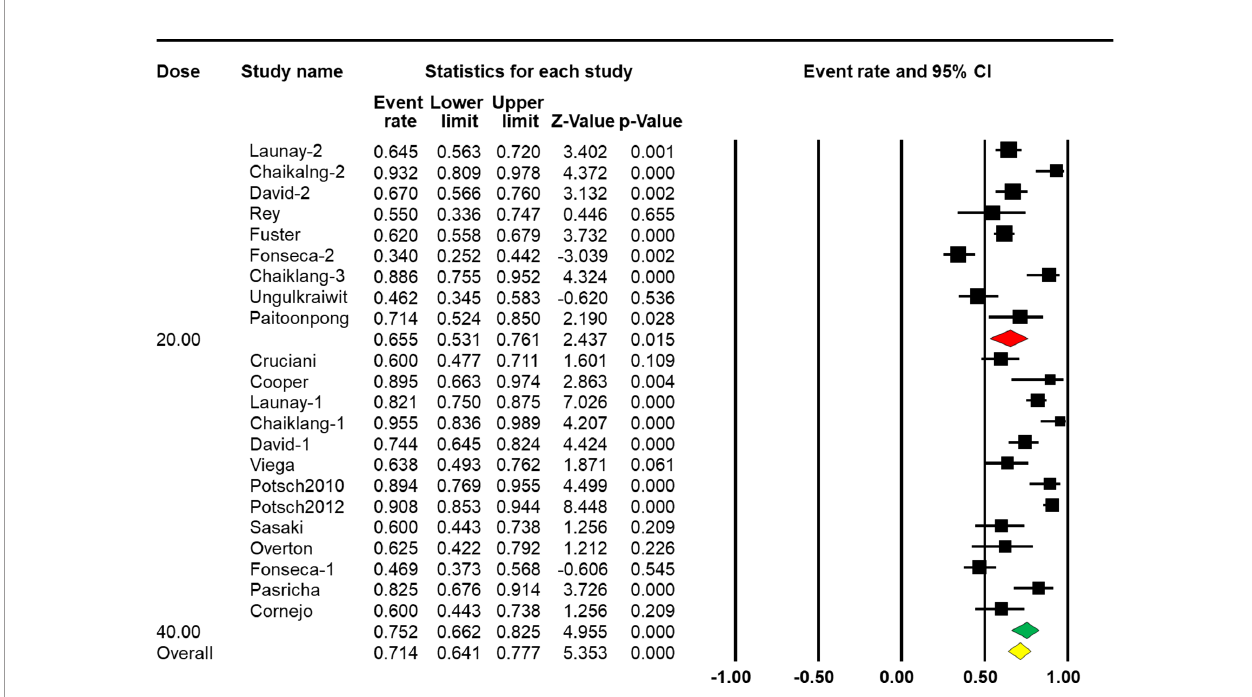
FIGURE 4 | Ef fi cacy of HBV vaccination at different doses (standard dose vs. double dose) on the response